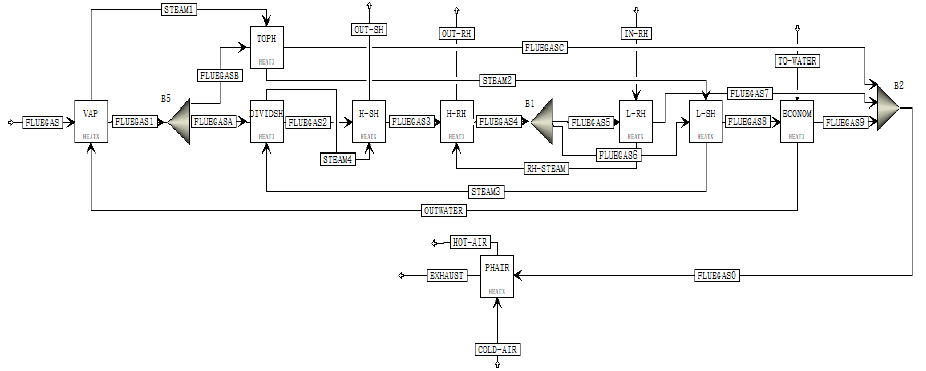
Figure 6. Heat exchange system module.